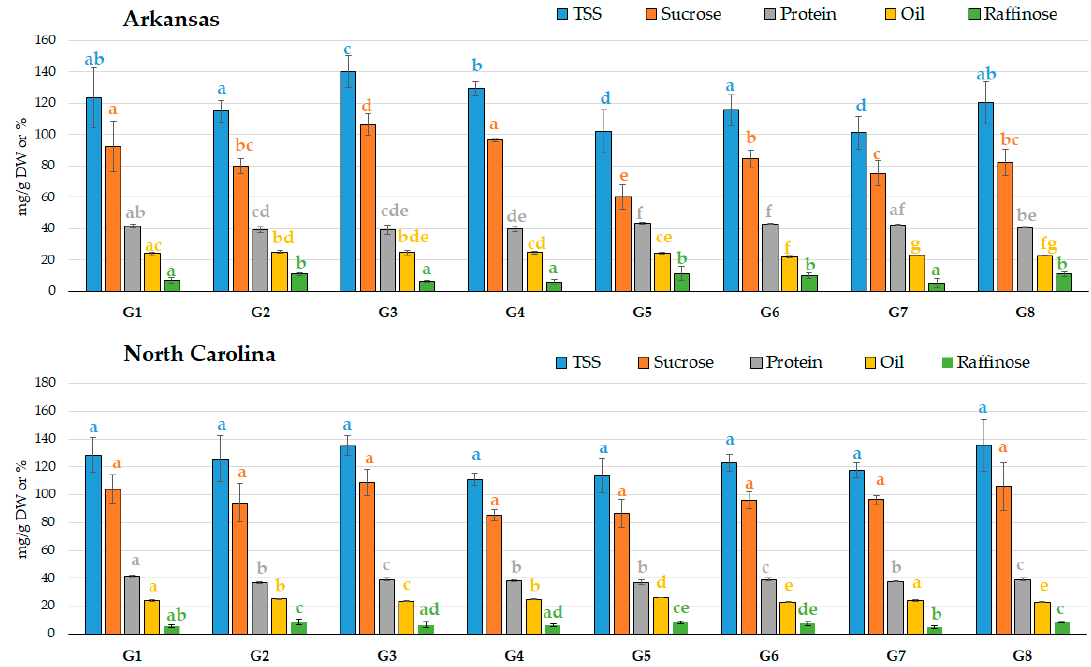
Figure 3. Total soluble sugars, sucrose, oil, protein, and ra ffi nose content in the eight soybean genotypes (G1 to G8) grown in two di ff erent locations (Arkansas and North Carolina). Total soluble sugars (TSS), sucrose, and ra ffi nose are presented in mg g − 1 DW, while protein and oil are expressed as percentages. Significant di ff erences between genotypes per location are indicated by di ff erent letters (ANOVA, Fisher LSD, p < 0.05, n = 3). Table 6. Features that present significant di ff erences between genotypes in each location (ANOVA, p < 0.05, n = 3) . For some of these features, a Fisher’s least significant di ff erence (LSD) test was performed and the results are shown in Figures 2 and 3. Glucose.1: glucose from matrix